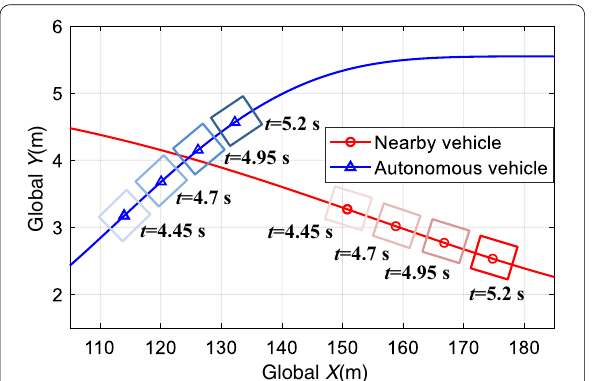
Figure 12 Longitudinal velocity of autonomous vehicle